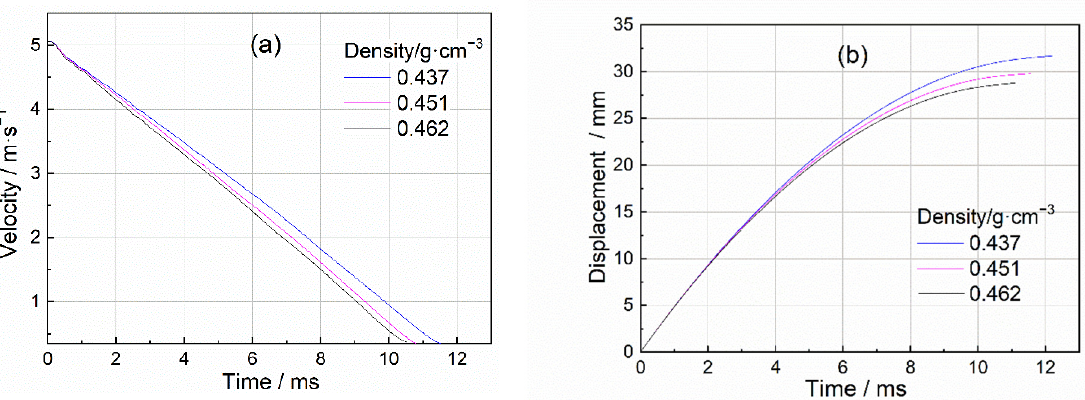
Figure 5. Typical acceleration and velocity curves for closed-cell Al foam.